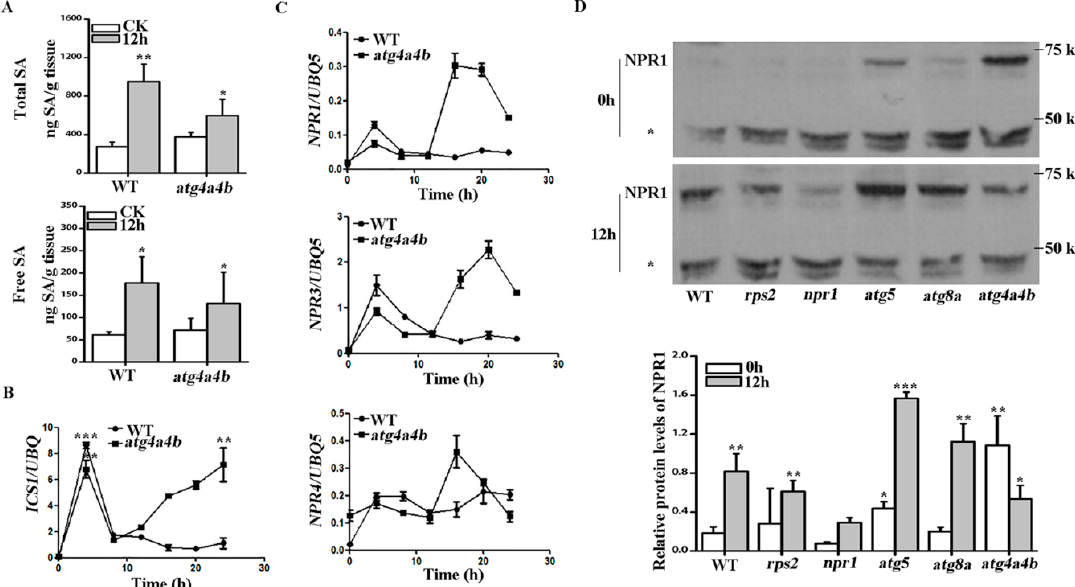
Figure 4. ATG4 inhibited salicylic acid (SA) consumption during AvrRpt2 induced autophagy-dependent HR. ( A ) Total SA and free SA contents in WT and atg4a4b under AvrRpt2 infection for 12